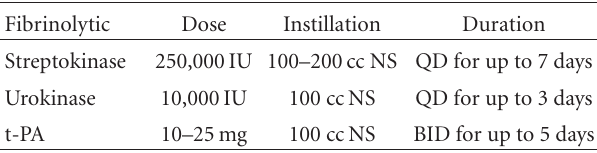
Table 3: Various intrapleural fibrinolytics (Adapted from Colice et al.